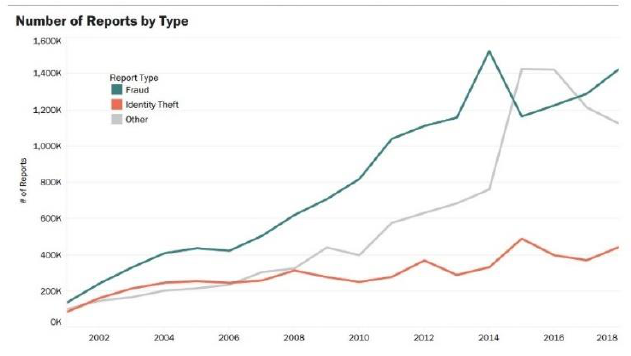
Fig. 3. Identity theft complaints from 2002 to 2018 (Source: